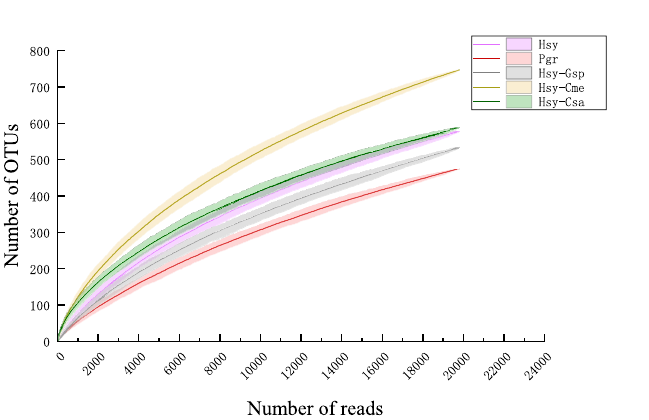
Figure 2. Bar chart of the Shannon–Wiener, Simpson, ACE and Chao1 indexes in Hsy, Pgr, Hsy-Gsp, Hsy-Cme and Hsy-Csa. The numbers above the bars represent the average of each index in different treatments. Different lowercase letters above the bars indicate significant differences in each index among treatments (P < 0.05).